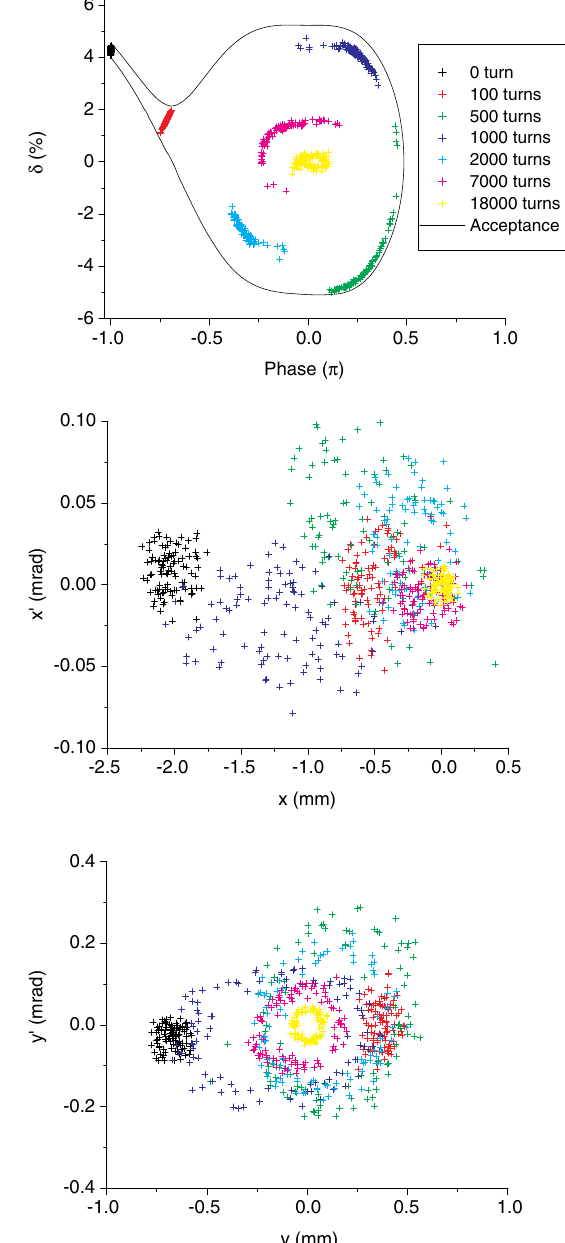
FIG. 4. Particle distributions in the longitudinal (top) and transverse (center and bottom) planes with up to 18000 turns following the injection (corresponding to 2.68 times of the damping time in the horizontal plane, 1.75 times in the vertical plane, and 2.58 times in the longitudinal plane). The closed orbit for the off-momentum injected beam (4.3%) is horizontally/ vertically shifted by − 1 . 4 mm = − 0 . 2 mm due to higher order dispersion terms and the introduced machine errors. The bunch is injected at x ¼ − 1 . 9 mm and y ¼ − 0 . 7 mm.